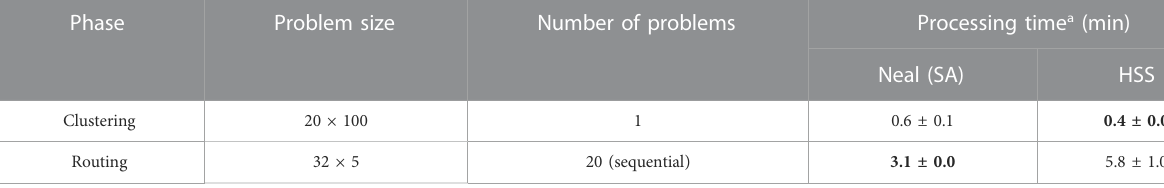
TABLE 6 Processing time for each solver in each phase. Phase